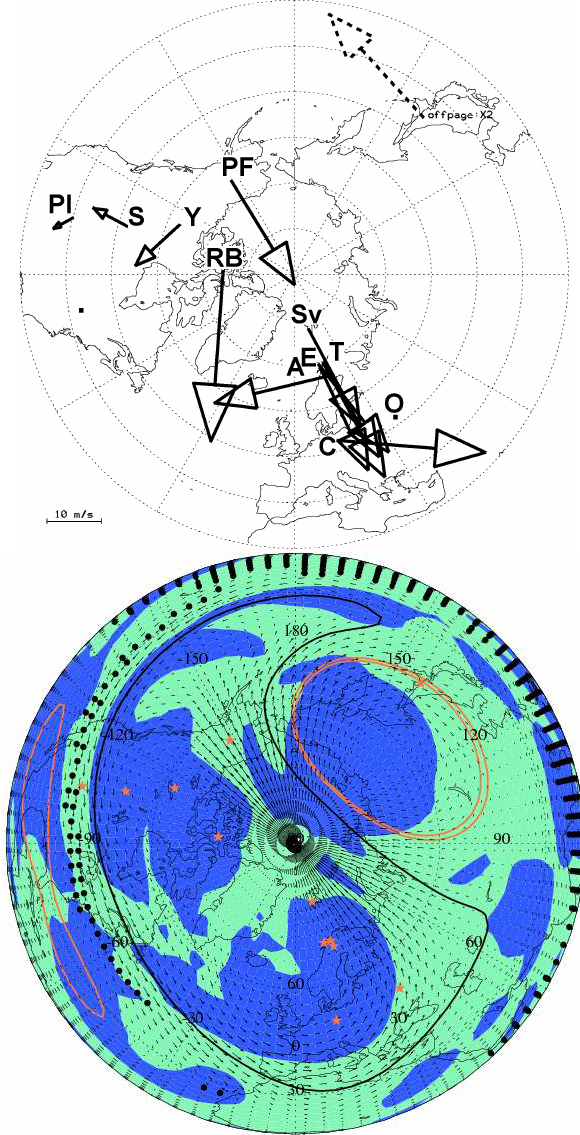
Fig. 8a. Evolution of the daily MetO winds (black arrows) at 2000K isentropic surface (bottom) and 3-day mean winds obtained at 12 radar locations (82km, top) for 20 January 2005. The dashed arrow indicates the speed is twice as big as that shown.